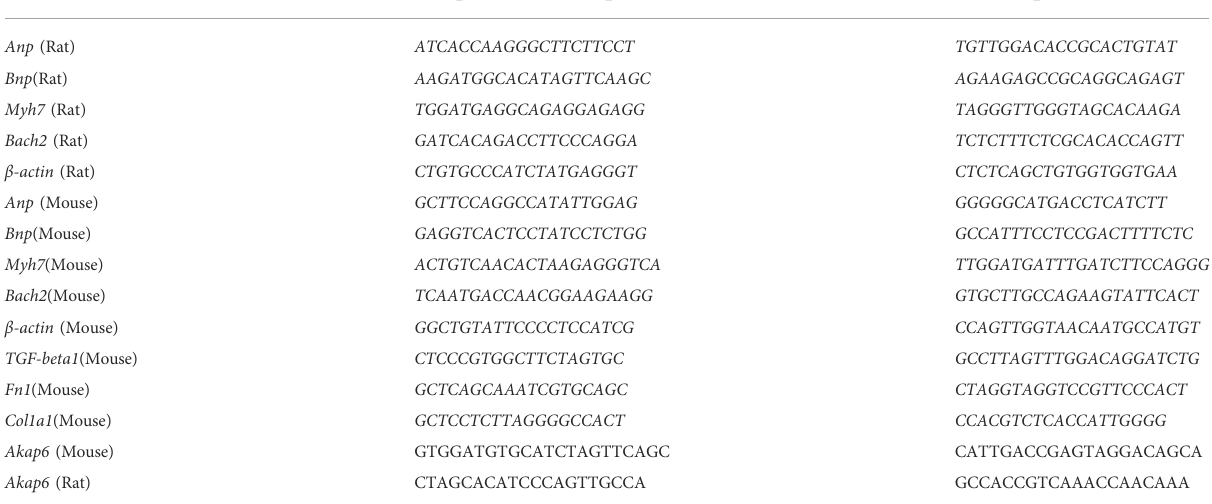
TABLE 1 Primers of